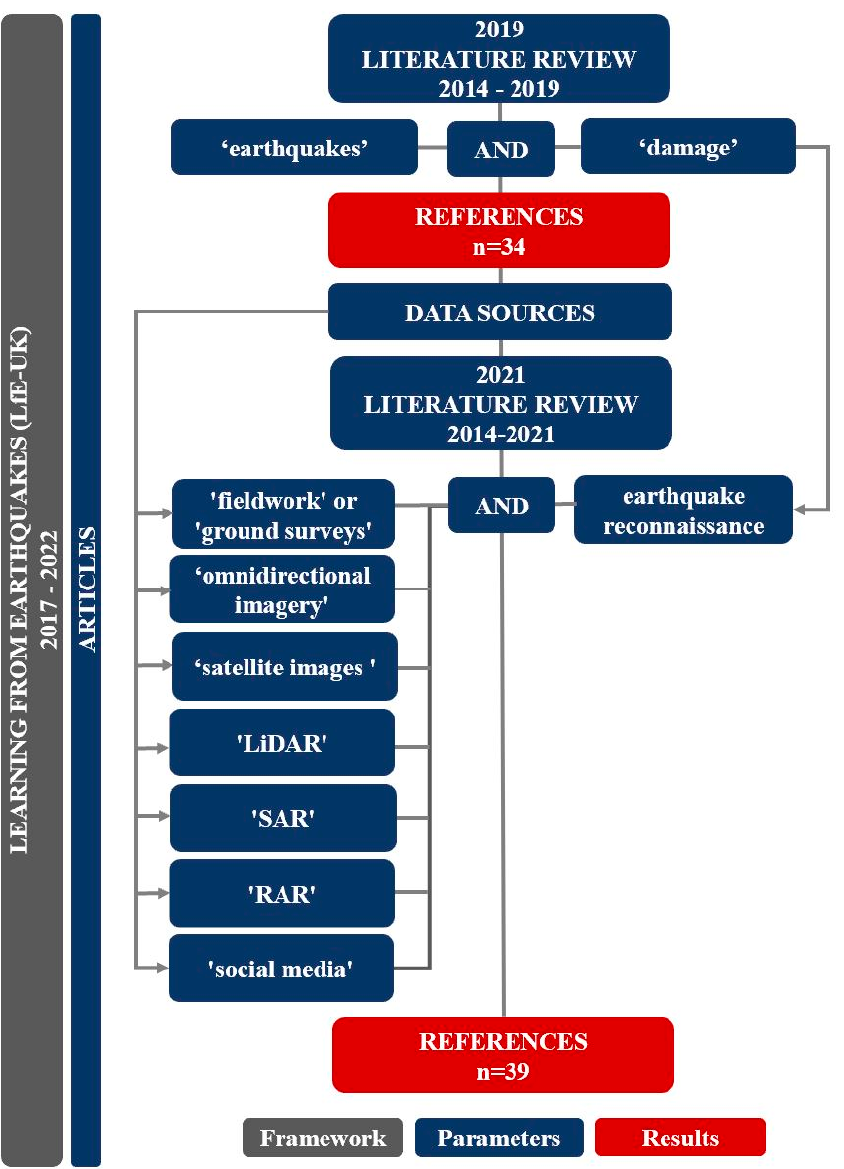
Figure 1. Flow diagram of the methodology applied to select the references for the literature review.